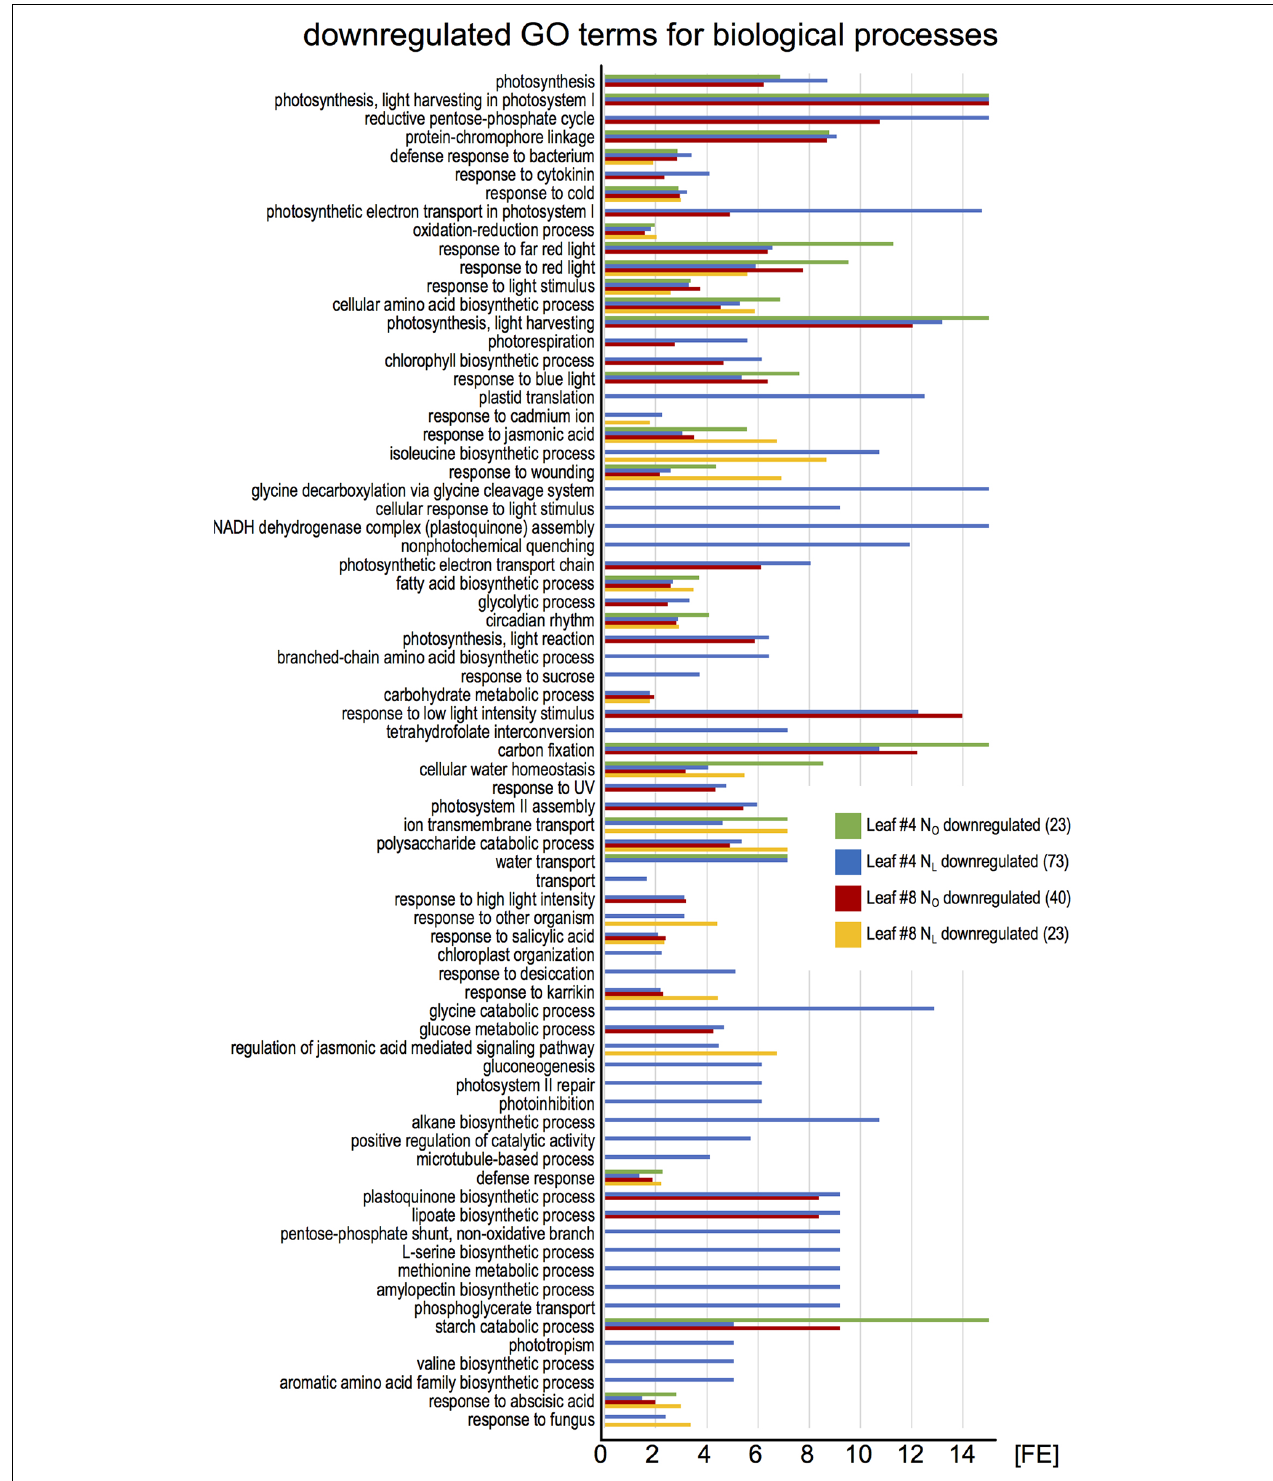
FIGURE 5 | Enriched Gene Ontology terms among downregulated leaf #4 genes. The downregulated genes in all samples (green pictograms in Figure 2 ) were analyzed for enriched Gene Ontology terms using the DAVID Bioinformatics Resources 6.8. The blue bars represent all significantly enriched GO_BP_DIRECT terms in N L leaves #4 ( P < 0.05). Those terms that were also enriched in other samples are shown as green, red, and yellow bars. The lack of a bar indicates that the fraction of downregulated genes in a GO term is not significantly higher than the overall fraction of downregulated genes. The numbers in brackets denote the count of enriched GO